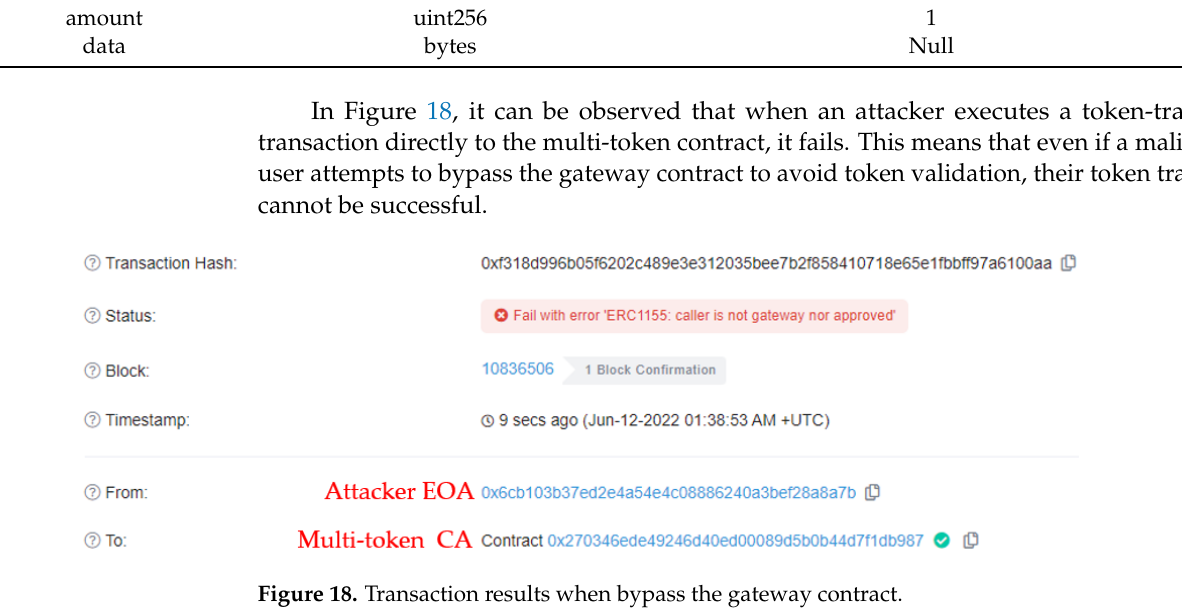
Figure 18. Transaction results when bypass the gateway contract.